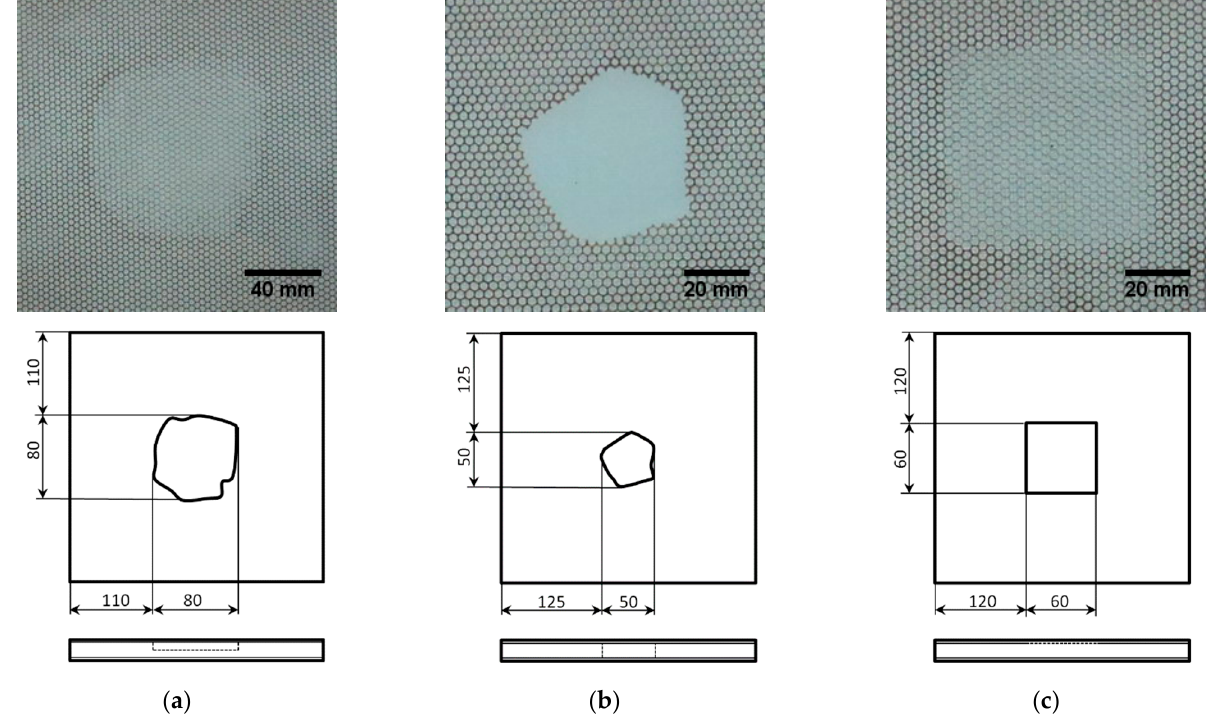
Figure 1. The images and schemes of the damaged sandwich plates: ( a ) partial local lack of the core {1}, ( b ) full local lack of the core {2}, ( c ) debonding between the core and the upper facing {3} [28,37] with permission from Elsevier.